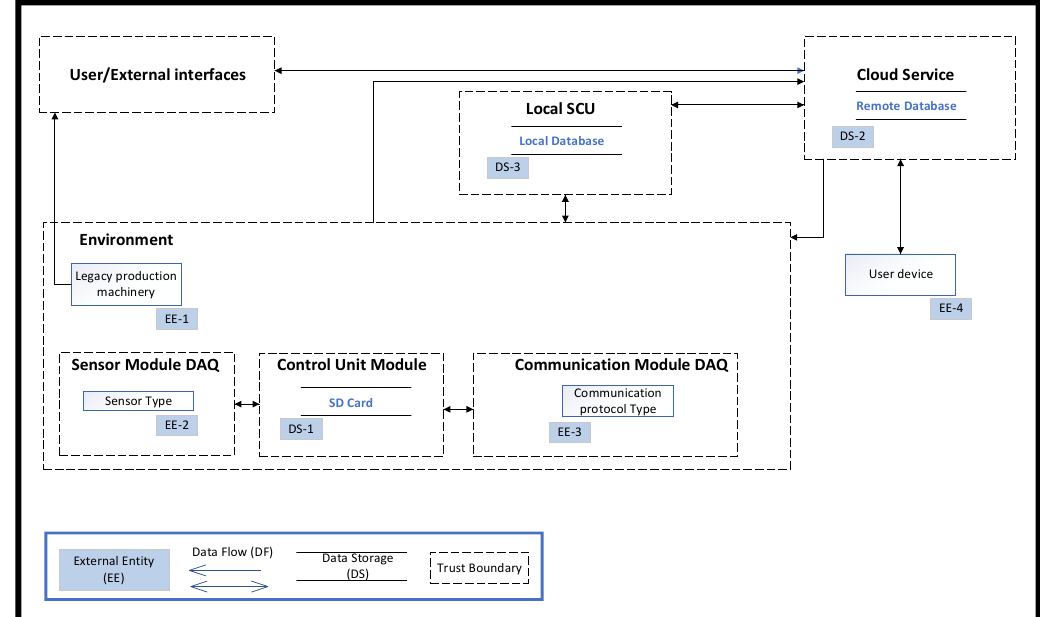
Figure 6. Data flow diagram of the connected legacy production machinery. DAQ: Data acquisition.